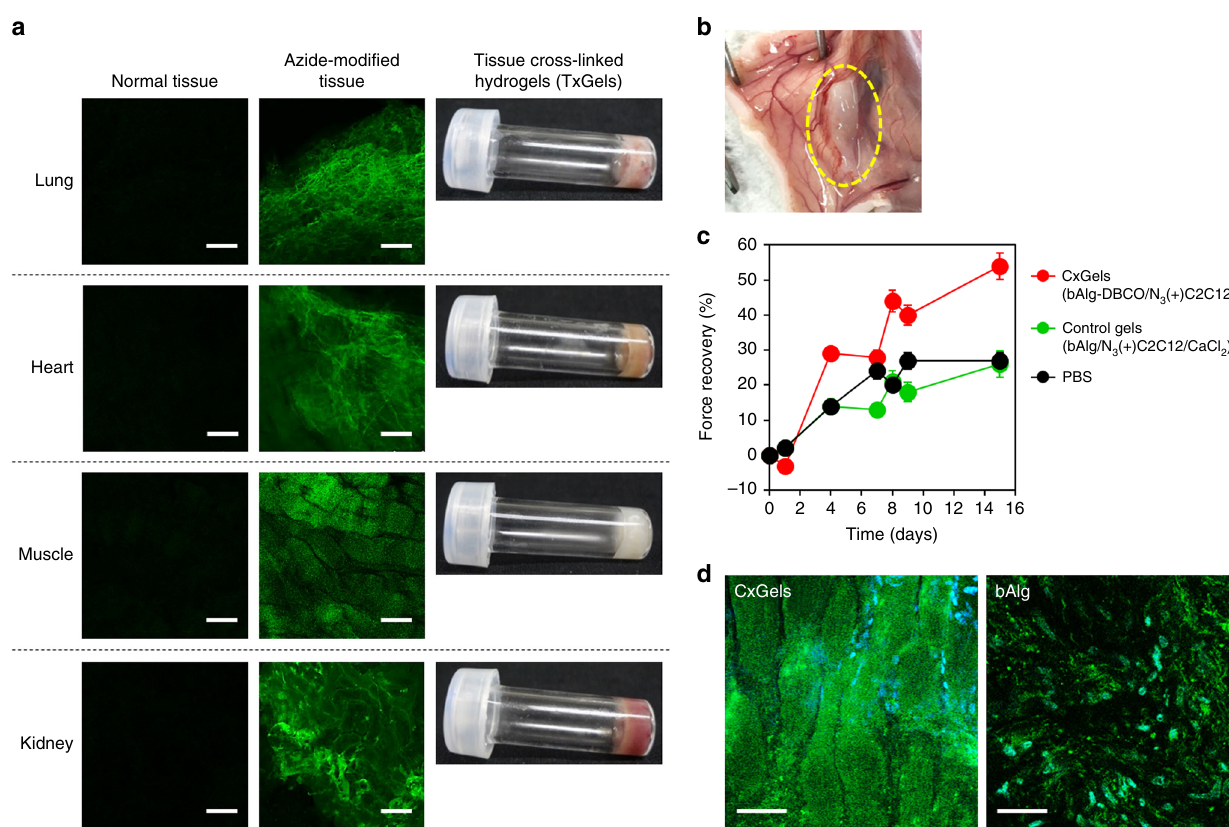
Fig. 5 Tissue cross-linked hydrogels (TxGels) and in vivo CxGels formation. a (left panels) CLSM images of normal mouse tissues treated with FITC-bAlg- DBCO solution. These tissues were carefully excised, then shredded and suspended with 500 µ L of FITC-labeled bAlg-DBCO (0.1%) solution at 37 °C for 30 min. After that, tissues were centrifuged and washed with PBS twice, then tissues were re-suspended with 1 mL of Live Cell Imaging Solution and observed by CLSM. Scale bars indicate 100 μ m. (middle panels) CLSM images of azide-modi fi ed mouse tissues treated with FITC-bAlg-DBCO solution. Mice treated with AC 4 ManNAz for continuous 7 days were killed and the tissues were excised carefully. These tissues were shredded and washed with PBS twice. These tissues were carefully excised, then shredded and suspended with 500 µ L of FITC-labeled bAlg-DBCO (0.1%) solution at 37 °C for 30 min. After that, tissues were centrifuged and washed with PBS twice, then tissues were re-suspended with 1 mL of Live Cell Imaging Solution and observed by CLSM. Scale bars indicate 100 μ m. (right panels) Photographs of tissue cross-linked hydrogels (TxGels) made through click reaction between azide- modi fi ed tissues and bAlg-DBCO solution (2%) ex vivo. Scale bars indicate 100 μ m. b Photographs of in vivo formed CxGels. LifeAct-GFP-expressing azide-modi fi ed C2C12 cells (4.0 × 10 6 ) were suspended with 200 μ L of bAlg-DBCO solution (2%) and immediately injected subcutaneously into the muscle layer of the back of each mouse. c Force recovery of injured femoral muscle treated with CxGels prepared through click reaction between LifeAct- GFP-expressing azide-modi fi ed C2C12 cells (5.0 × 10 6 ) and 250 μ L of bAlg-DBCO (2%) or C2C12 cells-encapsulating control physical gels, prepared through physical cross-linking reaction between 250 μ L of bAlg solution (2%) and CaCl 2 solution (0.5%) in the presence of azide-modi fi ed C2C12 cells (5.0 × 10 6 cells). Error bars: standard deviation ( n = 3). d Fluorescence images of LifeAct-GFP-expressing C2C12 cells in the CxGels or the control physical gels acquired 15 days after transplantation into injured muscle. Green: LifeAct-GFP, blue: Hoechst. Scale bars indicate 50 μ